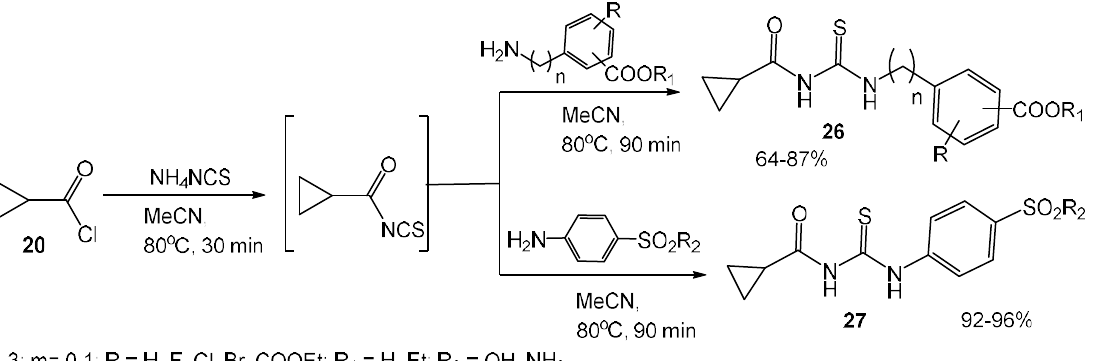
Fig. 7. “One-pot” synthesis of N- cycloalkylcarbonyl- N ′-arylthioureas